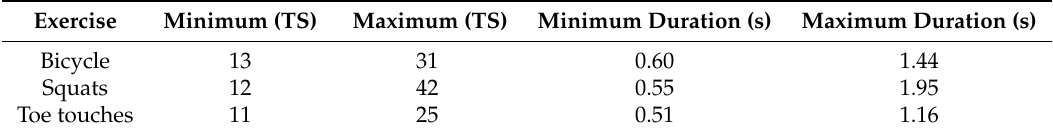
Table 1. The time duration for the fastest and slowest speed of each sports activities performed by the test participants. The abbreviation TS stands for time